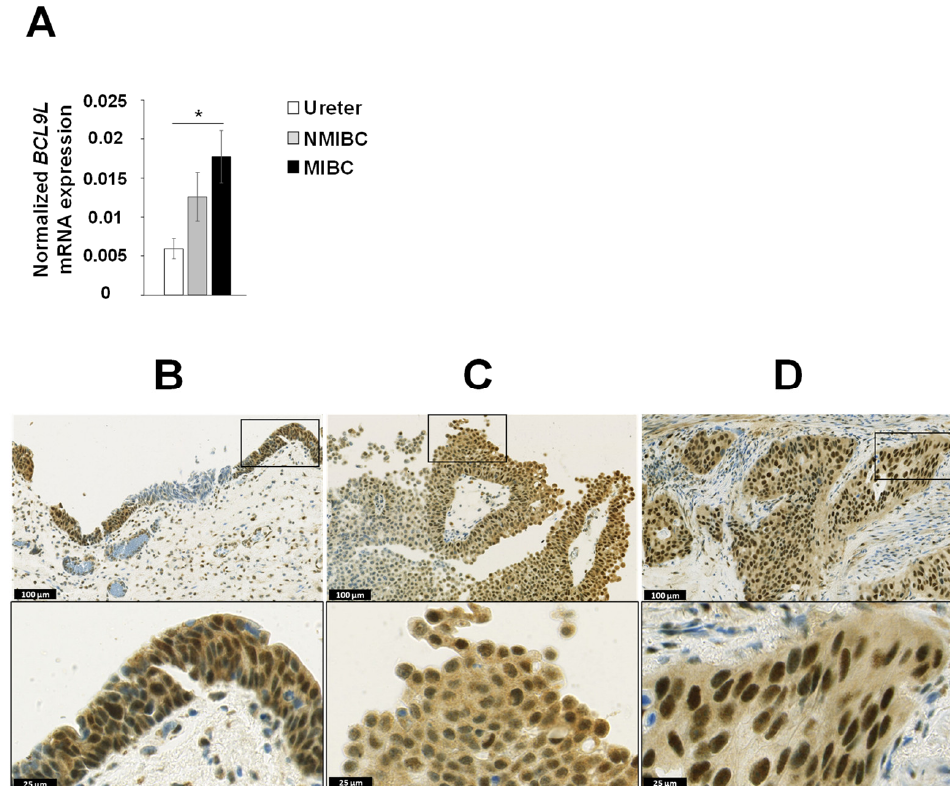
Figure 2. Expression of BCL9L in urothelium, dysplasia, and bladder cancer. ( A ) mRNA expression analysis of 8 matched NMIBC and corresponding MIBC patients and 3 normal urothelia (ureter) by qRT-PCR shows significantly increased expression in MIBC. The expression was normalised to housekeeping genes RPS13 and RPS23 . The data are expressed as mean ± standard deviation and statistical analysis was performed by non-parametric Mann–Whitney U -test with * p -value < 0.05. ( B – D ) Immunohistochemical staining of dysplastic urothelium, NMIBC, and MIBC. BCL9L is very heterogeneously expressed in different stages of urothelial dysplasia and bladder cancer. An increased expression was mainly found in dysplastic urothelium compared non or low dysplastic urothelium (B, patient 8), in peripheral cell layers of papillary NMIBC (C, patient 5), and in MIBC (D, patient 5). Scale bar upper images 100 µm, lower images 25 µm. Immunohistochemical staining of all patients are shown in Supplementary Figure S2.